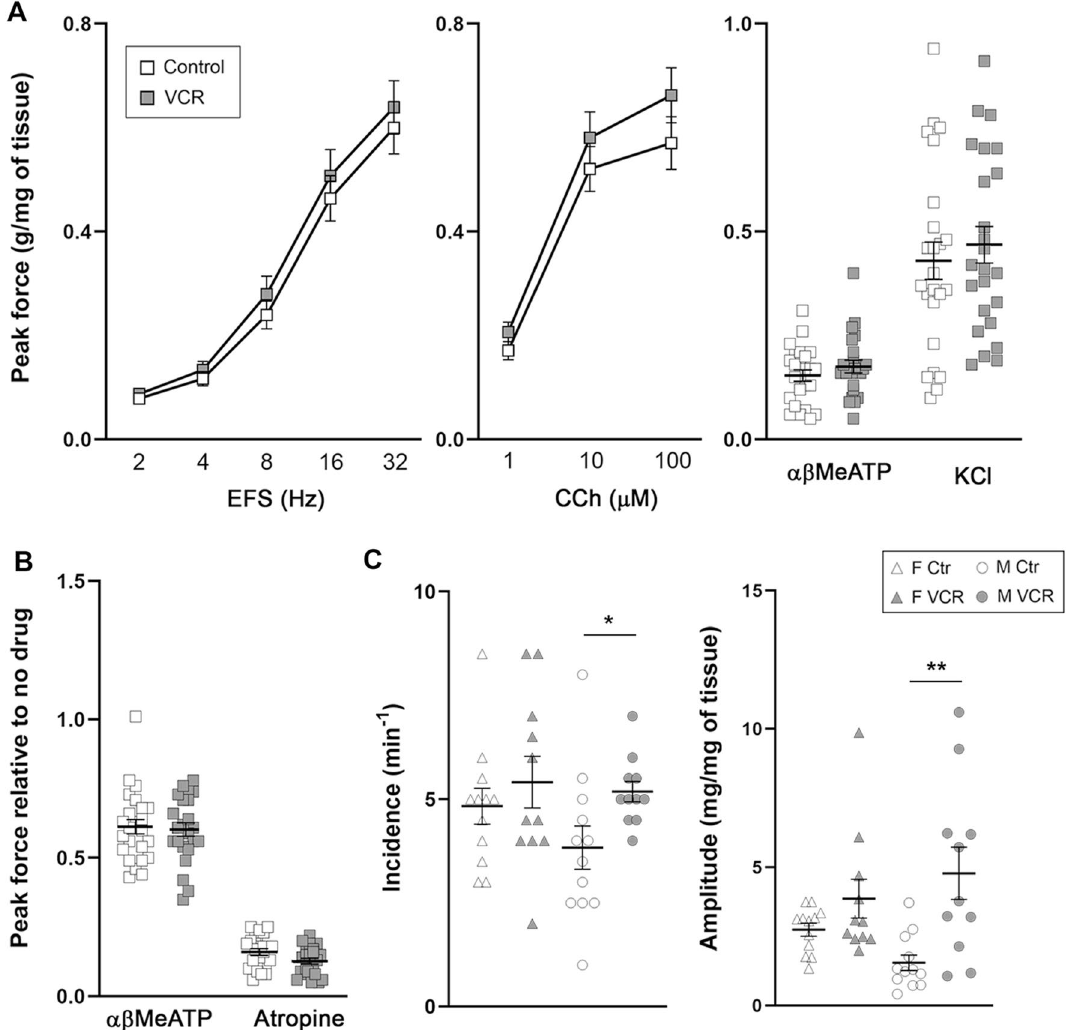
Figure 4. In vitro physiological evaluation of the bladder strips. A , peak contractile force in response to electric field stimulation (EFS, left), carbachol (CCh, center), and αβ-MeATP and KCl (right) [N = 6, 12 bladder strips per group per sex]. B , peak contractile force in response to EFS at 32 Hz after preincubation of αβ-MeATP and atropine. The force was normalized with tissue weight and expressed as relative to the response to EFS in absence of inhibitors. Open and grey boxes represent the control and VCR group, respectively. C , the amplitude, and the frequency of spontaneous contractions of the bladder strips. Open and grey triangles represent female mice in the control and VCR groups, respectively [12 bladder strips per group]. Open and grey circles represent male mice in the control [12 bladder strips] and VCR [11 bladder strips] groups, respectively. Mean ± SE, *p < 0.05, **p < 0.005 vs. the control group. Figures were prepared using Adobe Photoshop CS6 and GraphPad Prism 8.4.3 (https:// www. graph pad. com/ scien tific- softw are/